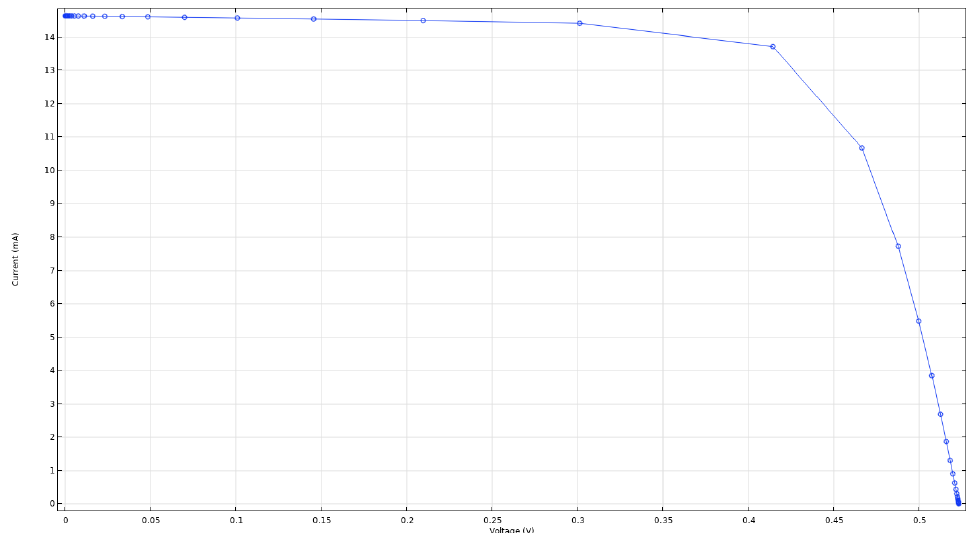
Figure 14. I-V curve of the solar cell with voltage (V) on the horizontal axis and current (mA) on the vertical